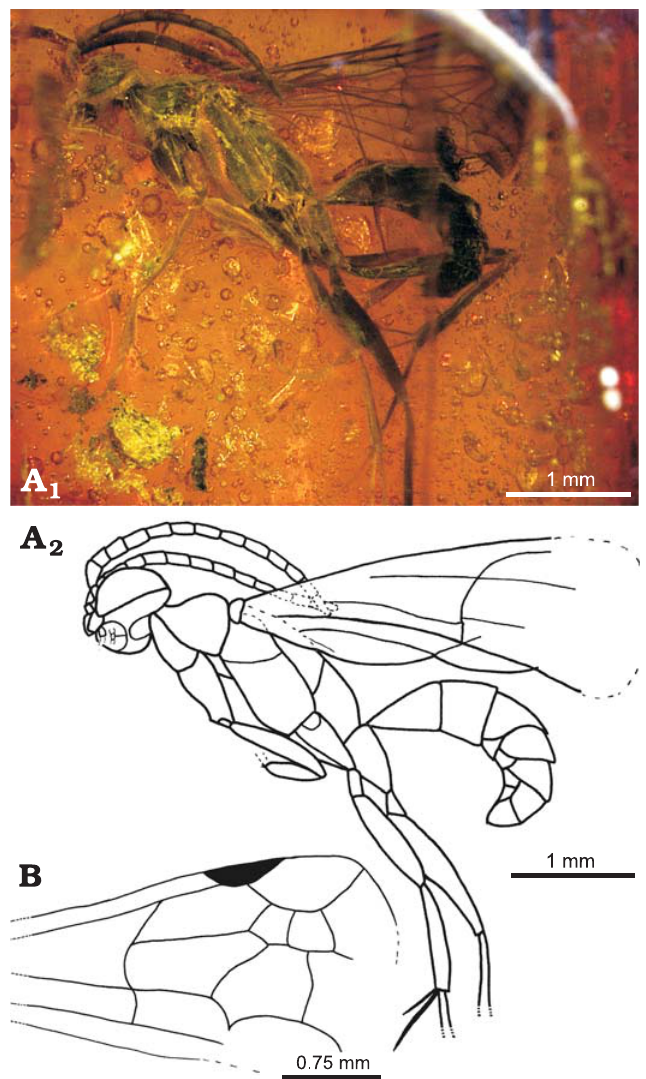
Fig. 2. Spider wasp Tainopompilus argentum sp. nov., holotype, OSAC Hy- 10-45, male specimen, from Early Miocene Dominican amber, Cordillera Septentrional, between Puerto Plata and Santiago, Dominican Republic. A . Specimen in lateral view. B . Forewing. Photograph (A illustrations (A 2 ,